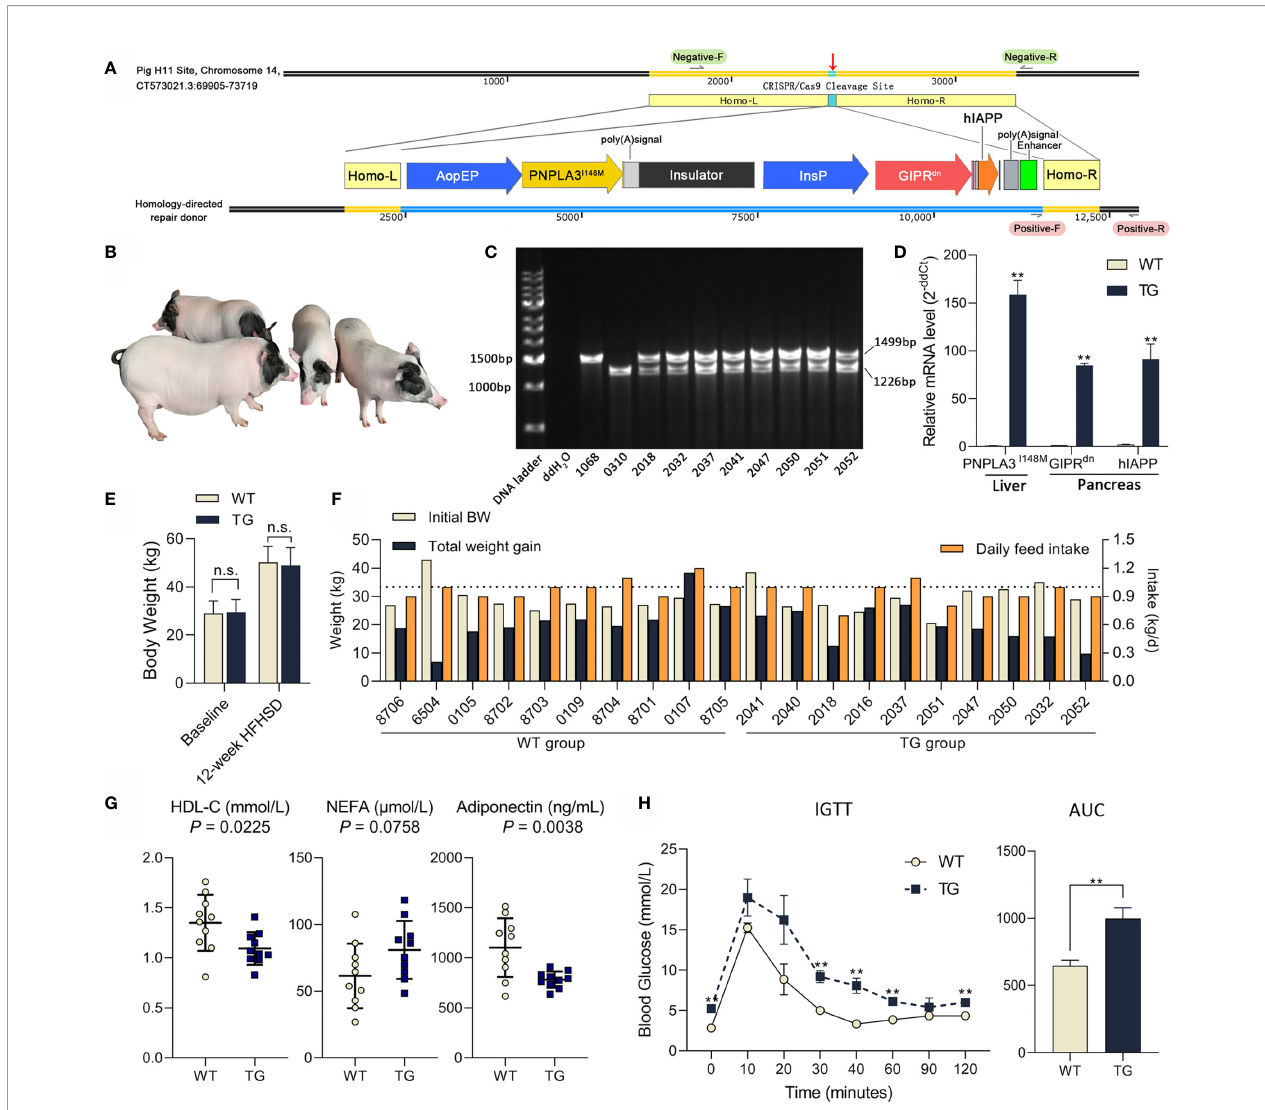
FIGURE 1 | Genetic modi fi cation, genotyping and metabolic status of Bama pigs. (A) Pig H11 sites on chromosome 14 were chosen for gene knock-in. Liver- speci fi c promoter ApoEP was used for PNPLA3 I148M expression and pancreas-speci fi c promoter InsP was used for GIPR dn and hIAPP expression. (B) Photo of transgenic Bama pigs. (C) PCR analysis of transgenic pigs, 1,499 bp product signed wild-type and 1,226 bp product signed transgene-positive H11 locus. No. 1068 was the wild-type sow, No. 0310 was the transgenic positive founder male, Nos. 2032, 2037, 2041, 2050, 2051 and 2052 were F1 transgenic heterozygotes. (D) Relative mRNA expression of PNPLA3 I148M in liver and GIPR dn and hIAPP expression in pancreas detected by RT-qPCR. n = 4 per group. (E) Average body weight at baseline and after a 12-week HFHSD. n = 10 per group. (F) Individual body weight at the start of HFHSD intervention (Initial BW), total weight gain and average daily feed intake during HFHSD intervention of animals. (G) Serum biochemical parameters; Symbols represent individual pig. (H) Blood glucose during IGTT and calculation of area under curve of IGTT test (0.6 g/kg, ip); n = 4 per group. Data are mean ± SD; statistical difference was performed using Student ’ s t-test; n.s., not signi fi cant, ** P <